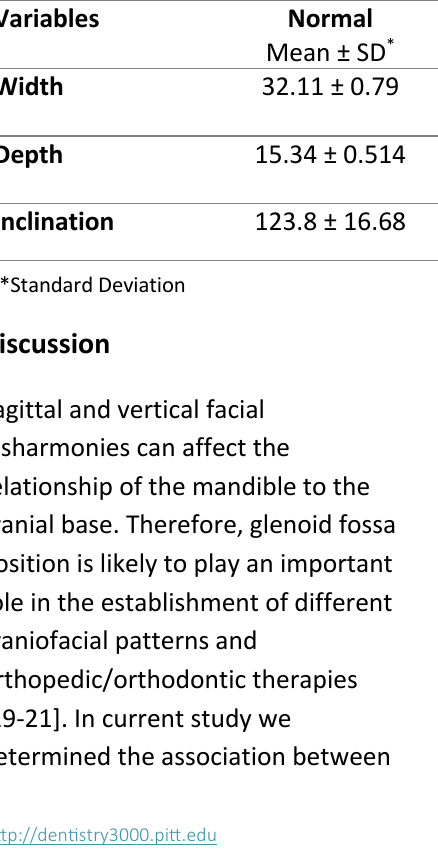
Table 2. Distribution of glenoid fossa morphology based on the width, depth, and inclination of glenoid fossa